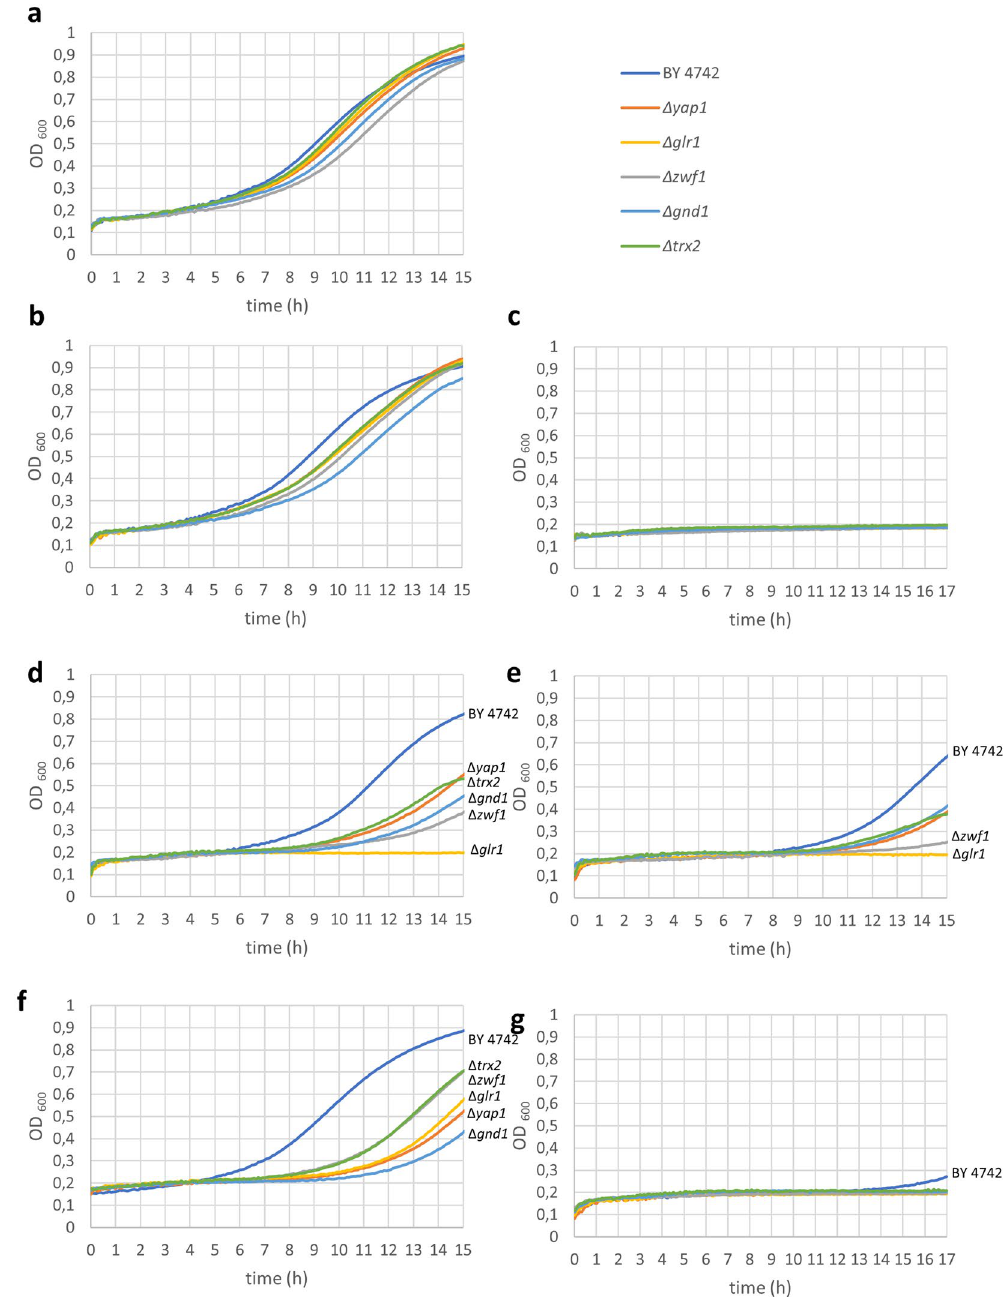
Figure 11. Effect of DBTS on the growth in CSM of wt BY4742 and Δ yap1 , Δ glr1 , Δ zwf1 , Δ gnd1 , and Δ trx2 mutant yeast cells in CSM and the synergistic effect of DMF with allicin. ( a , b ) are controls in the absence and presence of 0.5% DMF. ( c ) 5 µ M; ( d ) 10 µ M and ( e ) 25 µ M DBTS in the presence of 0.5% DMF, respectively. ( f ) 25 µ M allicin and ( g ) 25 µ M allicin in 0.5% DMF. The experiments were repeated twice with similar